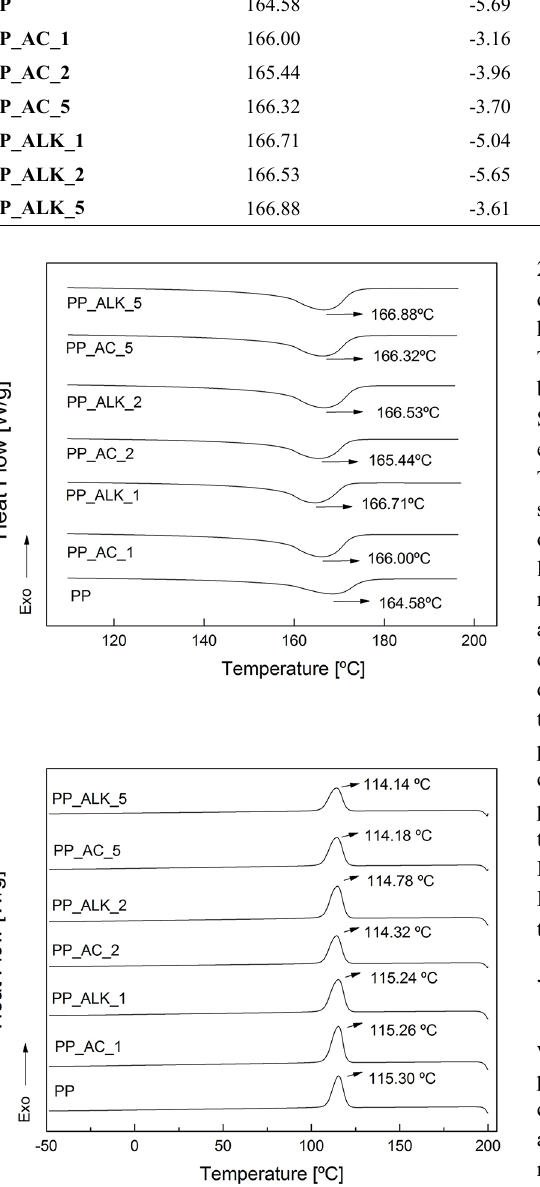
Figure 3. DSC curves for all PP and PP/Lignin blends (a) Melt endotherm obtained during second heating scan (b) Non-isothermal crystallization peak obtained during the cooling